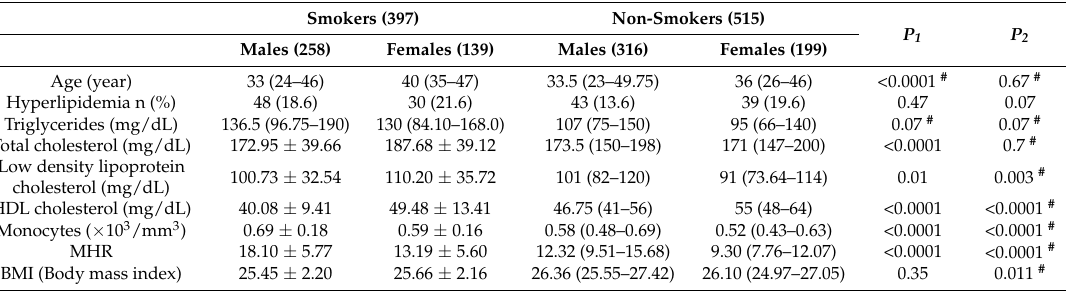
Table 2. Comparison of demographic and laboratory data between females and males.